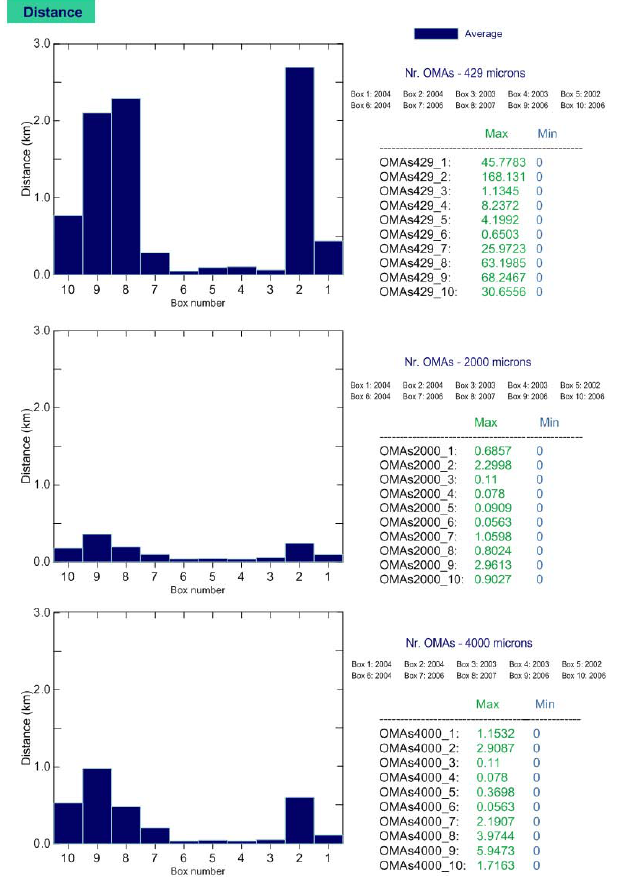
Fig. 9. Displacement predicted by the model for the three classes of